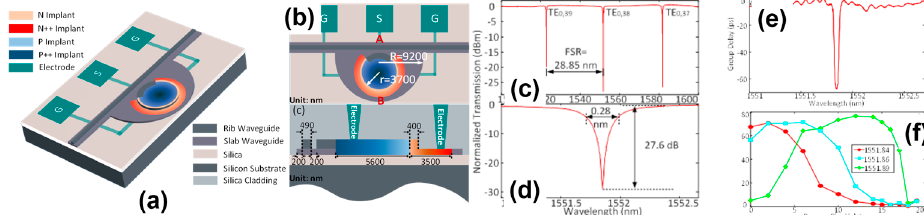
Figure 8. ( a ) Perspective view of an electrically tunable silicon-based on-chip microdisk resonator (MDR) reported in [93]. ( b ) Top view of the proposed MDR. ( c ) Measured transmission spectrum of the fabricated MDR, and ( d ) zoom-in view of the resonance of the fabricated MDR at the wavelength of 1551.84 nm. ( e ) Measured group delay of the resonance WGM_0,38 in the fabricated MDR and ( f ) electrical tunability of the group delay at three different wavelengths. Courtesy of Jianping Yao [93].